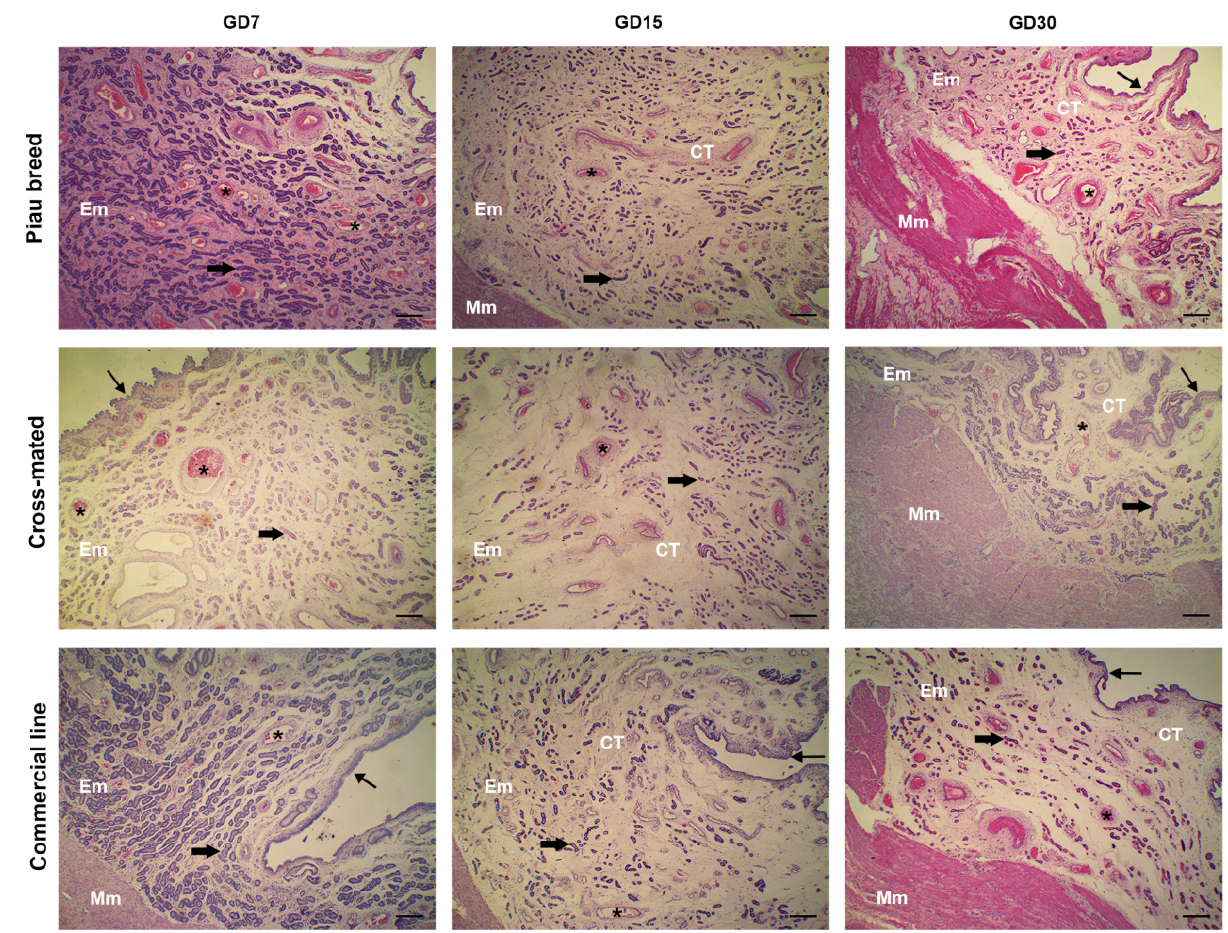
Figure 1. Histological sections of the uterus from the Piau breed, cross-mated (Piau breed x commercial line), and commercial line females at 7, 15, and 30 days of gestation (GD). The endometrium (Em) was composed of an epithelium (thin arrow) supported by a connective tissue (CT) with blood vessels (*) and endometrial glands (thick arrows). Note the presence of myometrium (Mm) composed of smooth muscle cells. Hematoxylin and eosin. Scale bar: 50 μ M.